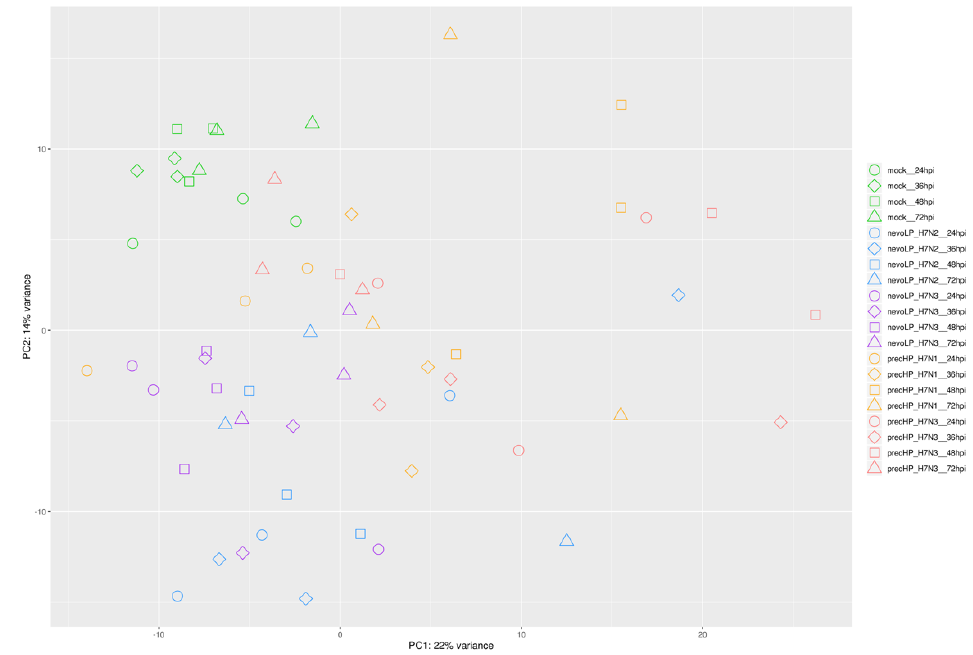
Figure 1. Principal component analysis of the normalized gene counts of the host genes.